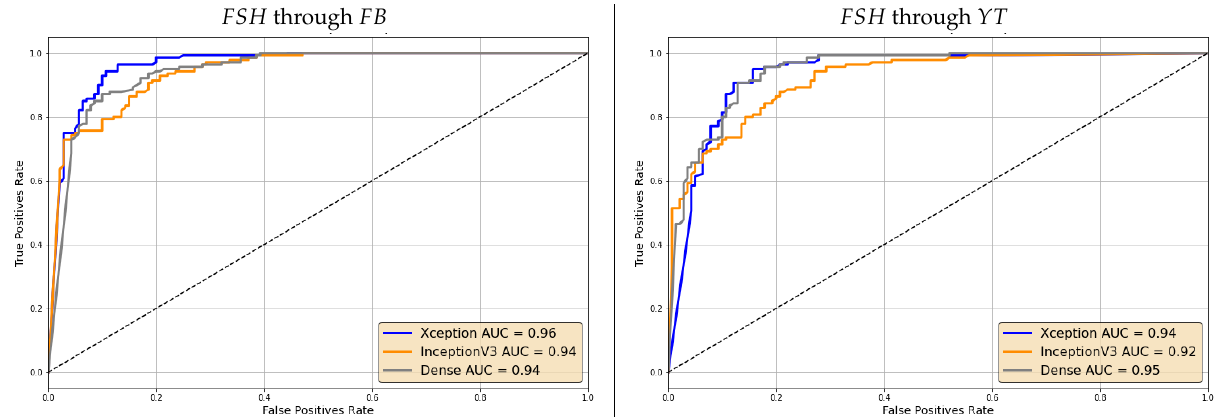
Figure 10. ROC curves of the video-based decision through specialized models on FSH videos shared on Facebook ( left ) and YouTube ( right